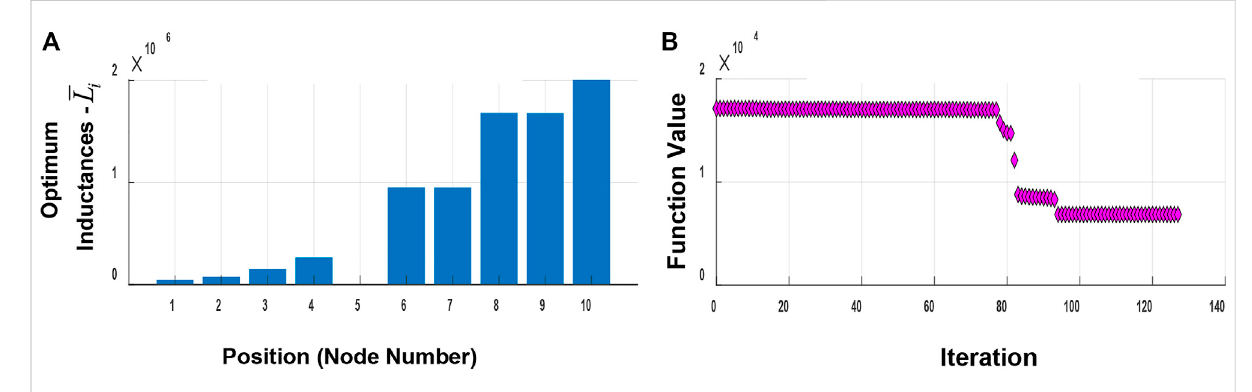
FIGURE 4 Optimal values of the dimensionless shunted